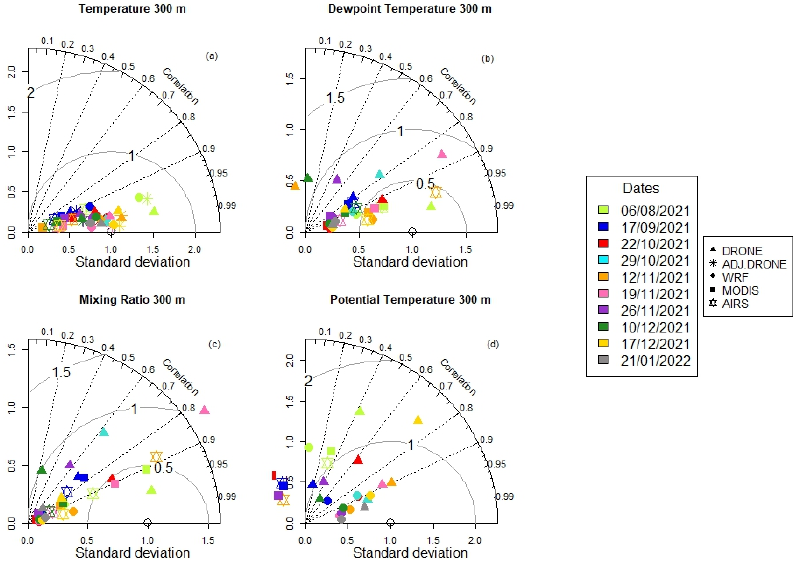
Figure 5. Normalized Taylor Plots for 10 measurement events up to 300 magl. of different atmospheric variables: ( a ) Temperature, ( b ) Dewpoint temperature, ( c ) Mixing ratio, and ( d ) Potential temperature.